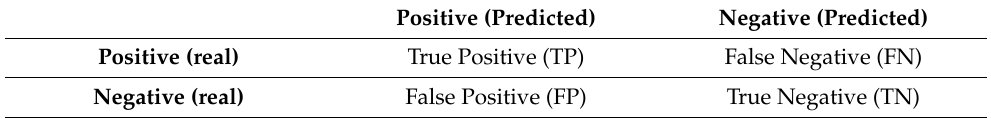
Table 2. Confusion matrix.